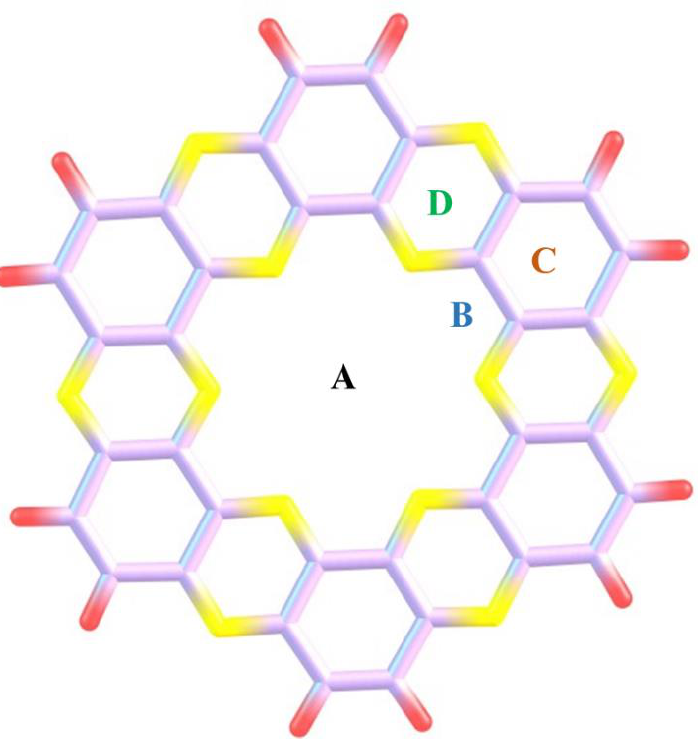
Figure 2. Optimized geometry of C 2 N surface with four binding sites (A, B, C, and D) at the M05- 2X/6-31++G(d,p) level of theory (yellow shows nitrogen, red represents hydrogen and light purple represents carbon).